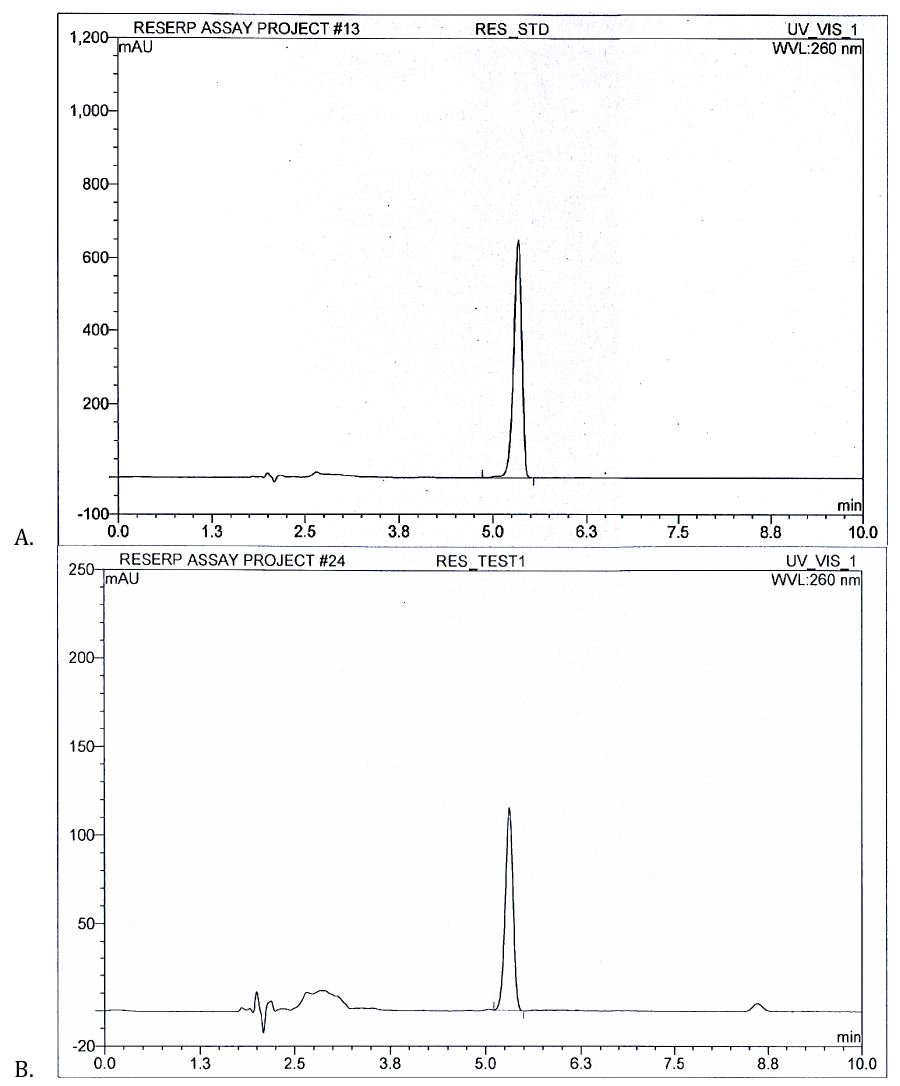
Figure 3. ( A ) RES standard peak ( B ) R. serpentina test extract resolved peaks at 5.3 min for RES quantification analysis using developed RP-HPLC method at 260